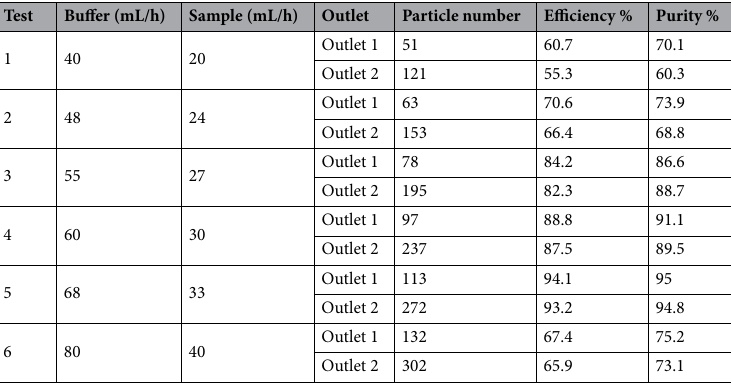
Table 4. Experimental test results for standard particles at various flow rate.